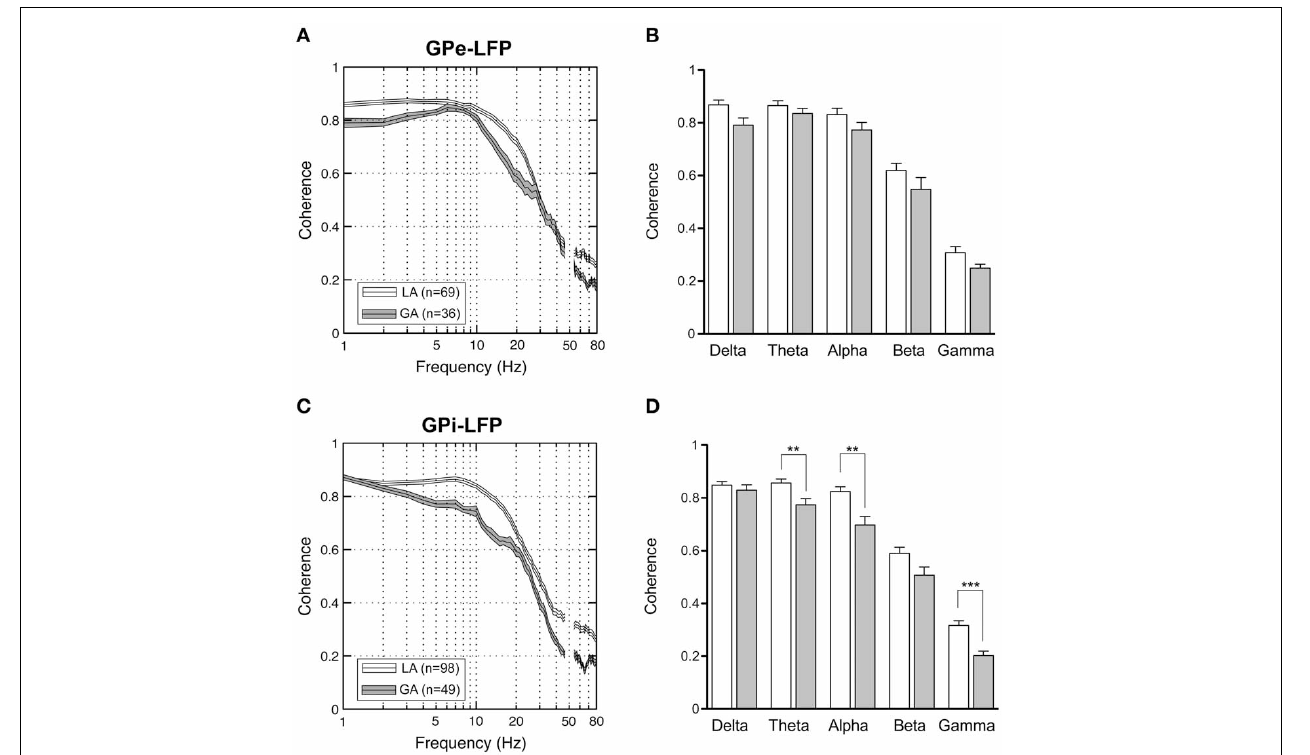
FIGURE 8 | LFP–LFP coherence analysis of pallidal LFPs. For each pair of LFP recordings from GPe and GPi of patients operated under LA and GA, respectively, coherence was computed and averaged. (A,C) Grand averages of coherence spectra (mean ± s.e.m.) for GPe (A) and GPi (B) recordings (frequency range, 1–80Hz). Highest coherence was